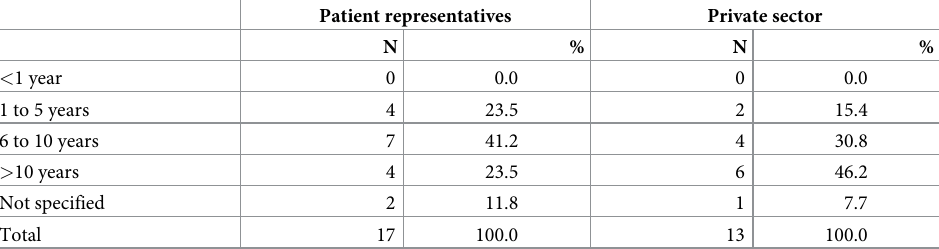
Table 3. Experience of the respondents in medical research (in years) a